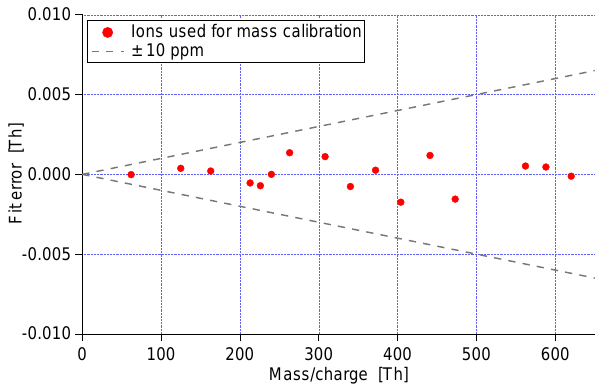
Fig. 3. Fit errors of the ions used for mass axis calibration. Gaussian fits were made to 16 peaks in the W-mode ion spectrum from JPAC. These peaks were attributed to specific elemental compositions and used for mass calibration. The selected peaks contained nitric acid, fluorinated acids, and organics to span the entire mass range of in- terest. The resulting errors between the fit masses and the assumed elemental compositions (red dots) where all well within ± 10ppm accuracy (grey dashed lines), strongly suggesting that all chosen peaks were correctly